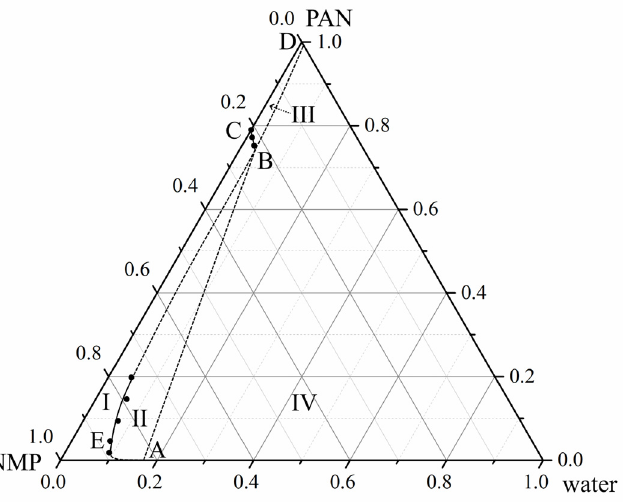
Figure 6. A ternary phase diagram of a mixture of PAN with NMP and water.